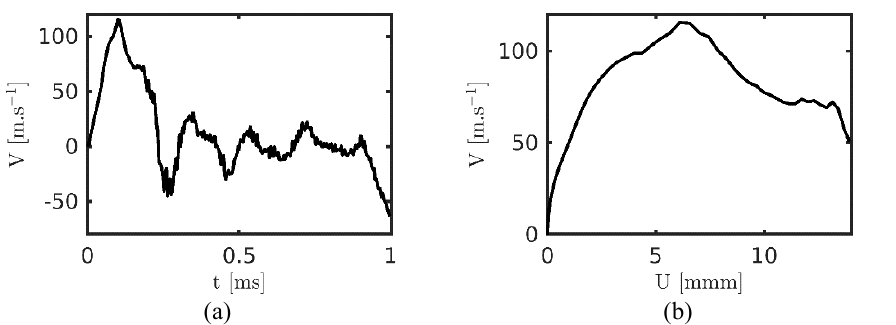
Figure 6 : (a) Speed in the back face of the plate (m.s -1 ) vs. Time (ms); (b) Speed in the back face of the plate (m.s -1 ) vs. displacement